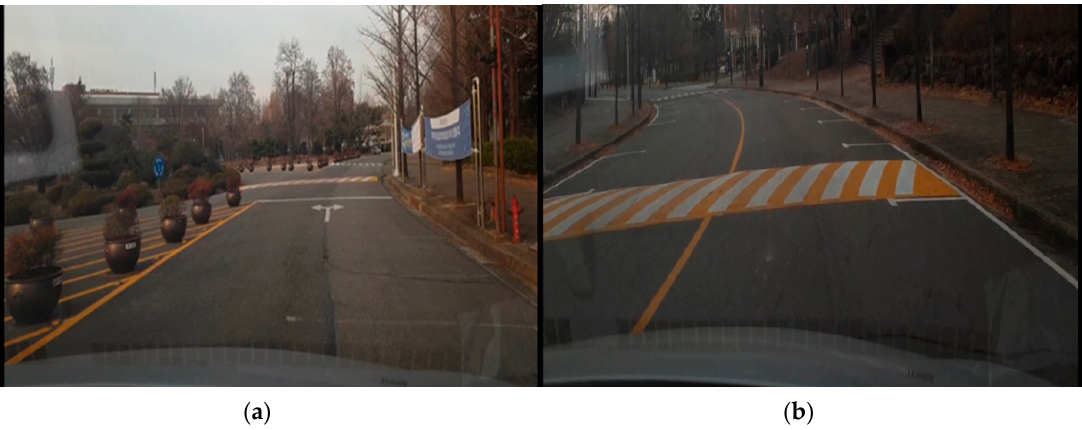
Figure 6. Images from video recording of data collection experiments: ( a ) case I; ( b ) case II.